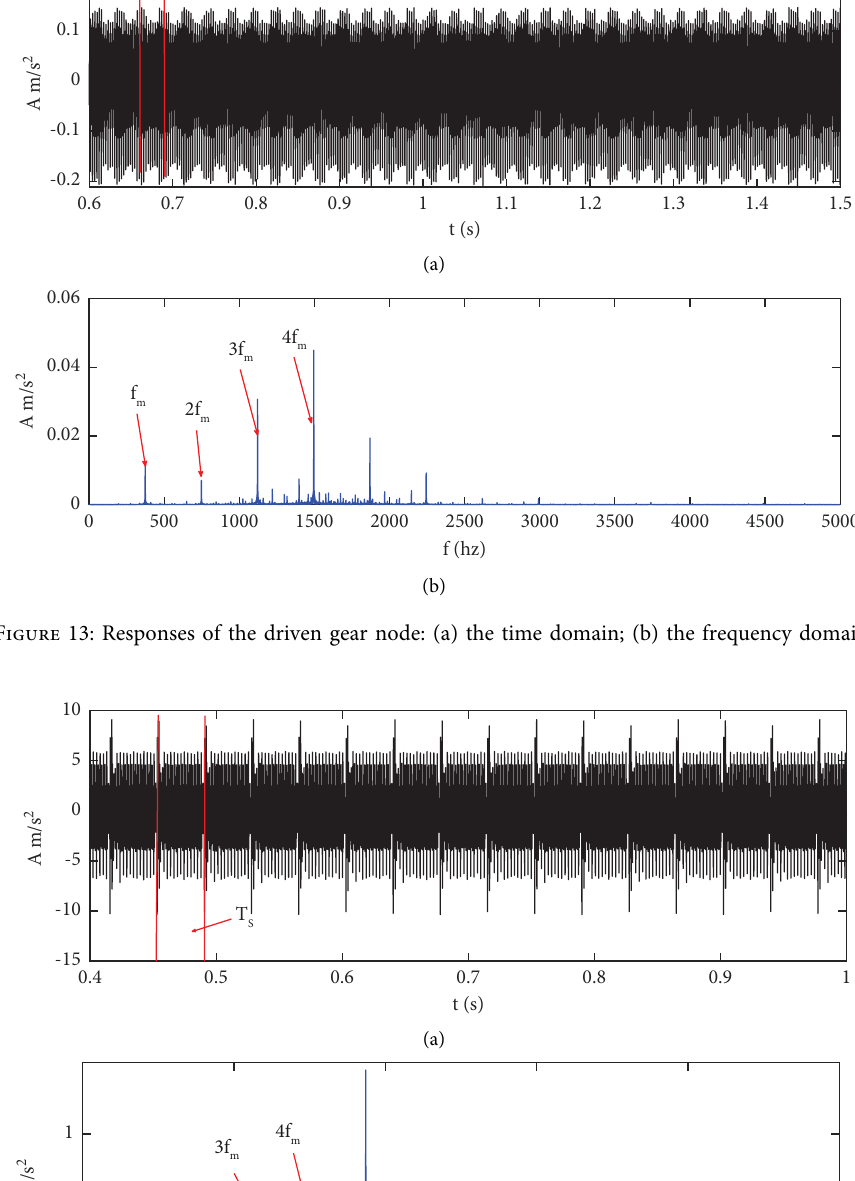
Figure 15(b), the meshing frequency f sponding components of the doubling frequency 3 f clearly found. Moreover, the gear fault frequency is mainly concentrated in the gear meshing frequency band.